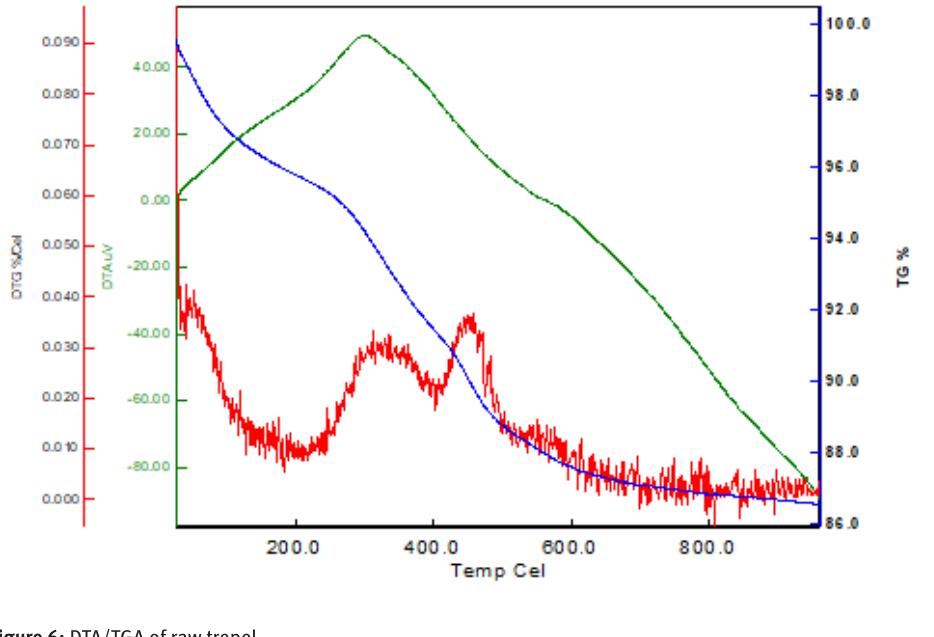
Figure 6: DTA/TGA of raw